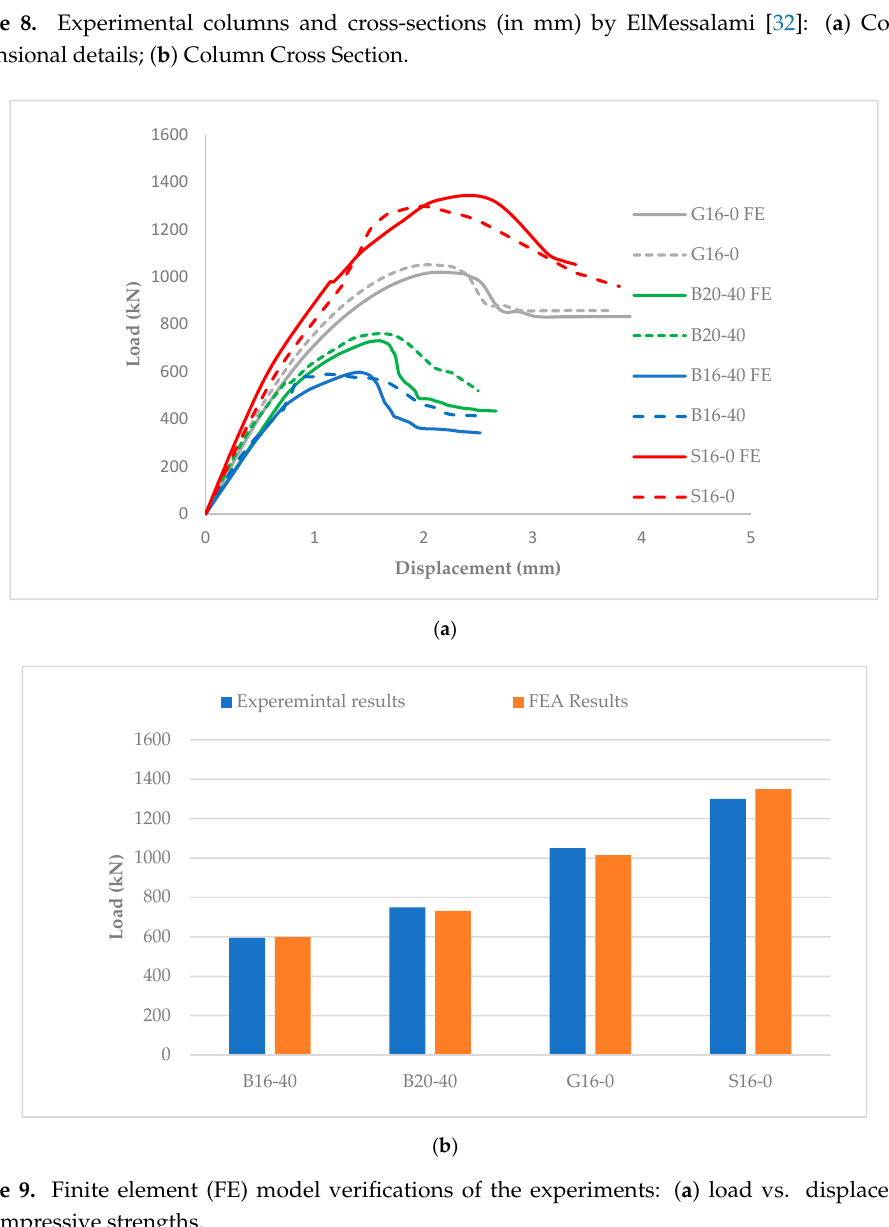
Figure 9. Finite element (FE) model verifications of the experiments: ( a ) load vs. displacement; ( b ) compressive strengths.